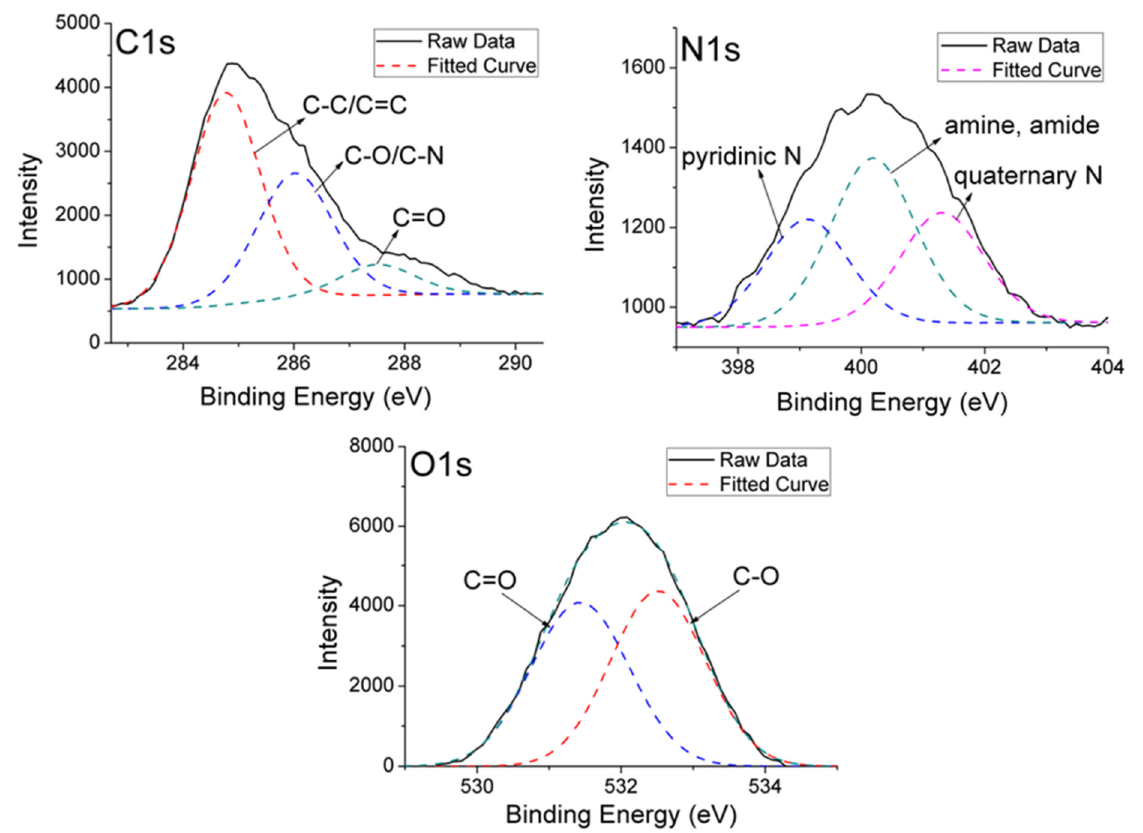
Figure 2. XPS of C 1s, N 1s and O1s surface-level spectra of CS180. Table 1. Elemental composition of CNDs.